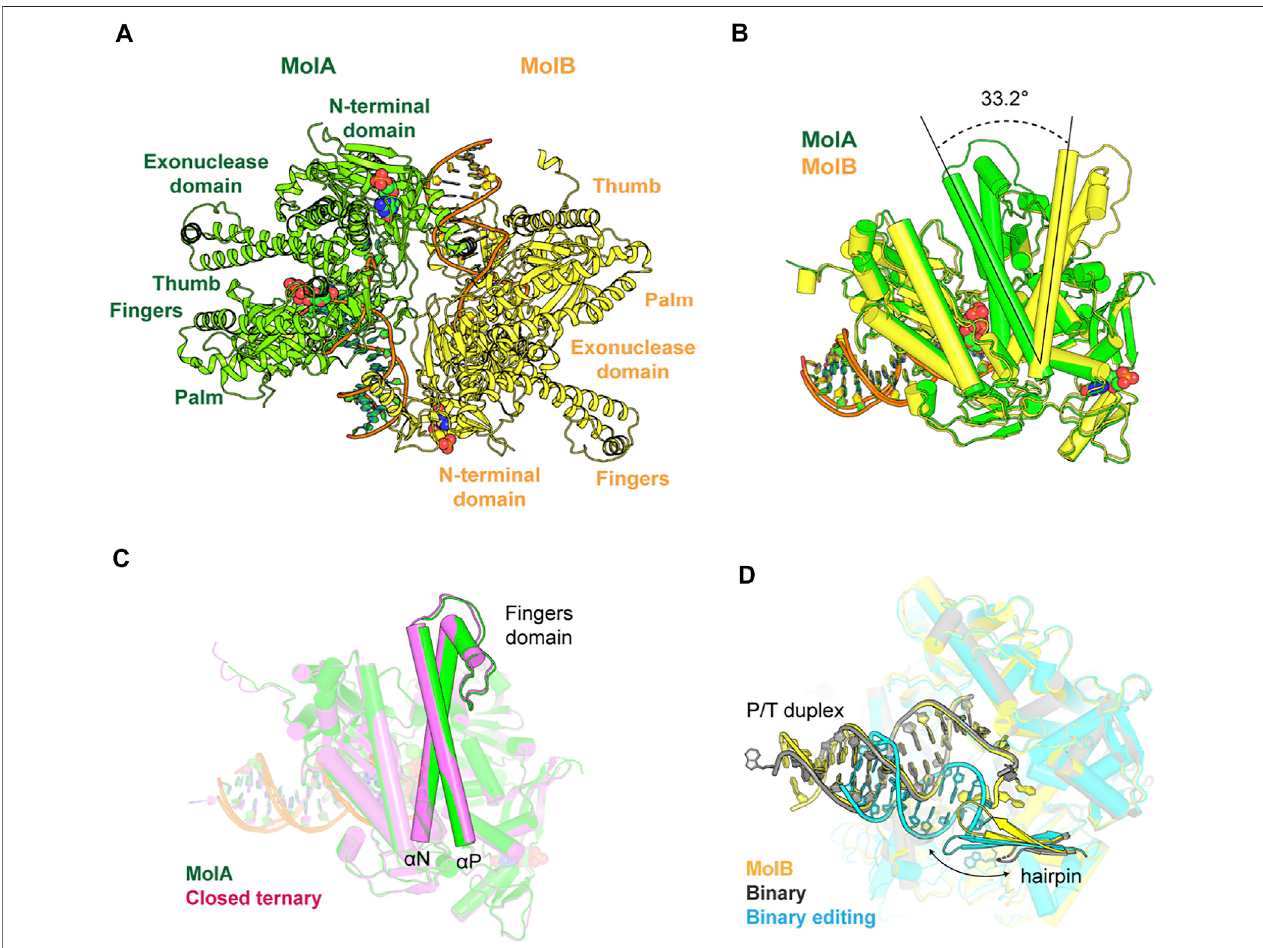
FIGURE 1 | Overall structure of RB69pol-DNA complexes. (A) Structures of the ternary complex (MolA, green) and the binary complex (MolB, yellow). Nucleotide molecules are shown as cartoons and spheres. (B) Superimposition of ternary and binary complexes and the conformational change of the Fingers domain is shown as thetwo-sideddashedline. (C) SameconformationoftheFingersdomainsofMolA(green)andaclosedternarycomplexreportedpreviously(magenta,PDBID1ig9). (D) Different topologies of the P/T duplex and hairpins of MolB (yellow) and other binary complexes (PDB ID 3l8b, 1clq).